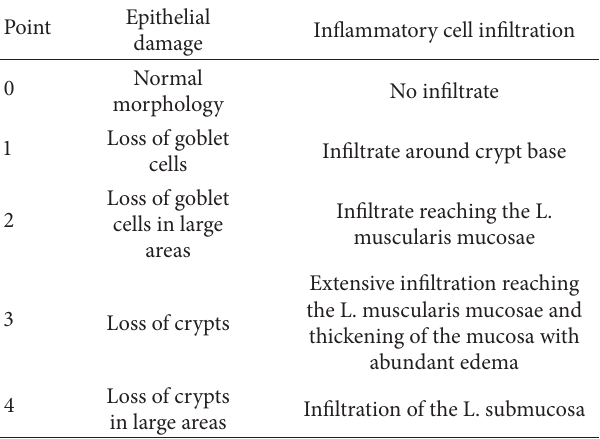
Table 2: Histological scoring system used in this